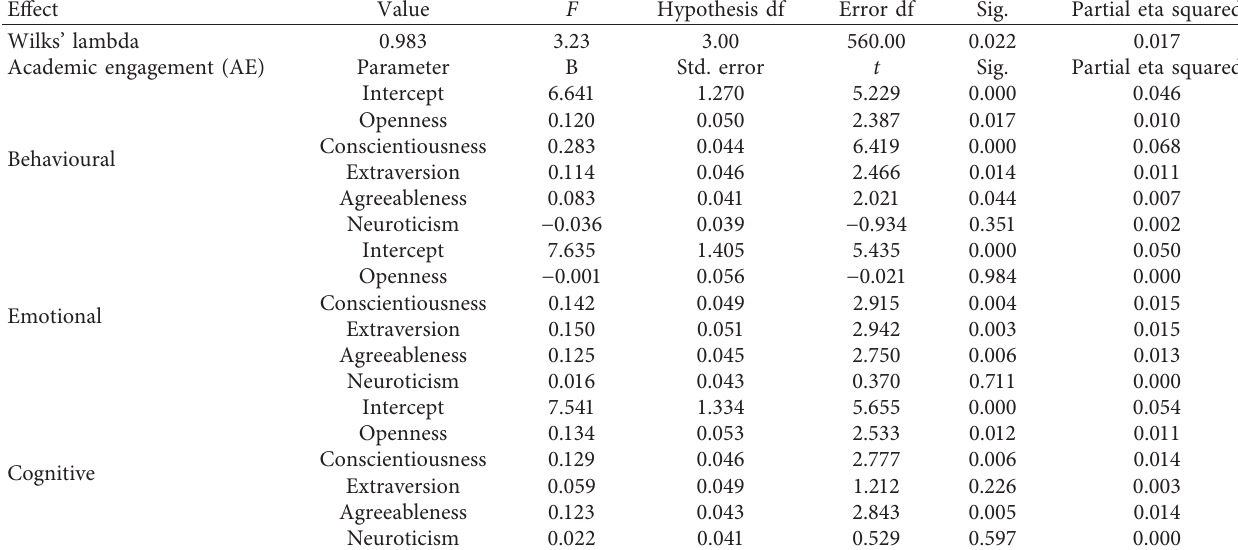
Table 4: Dimensional multivariate multiple regression (MMR) results for personality trait (PT) and academic engagement